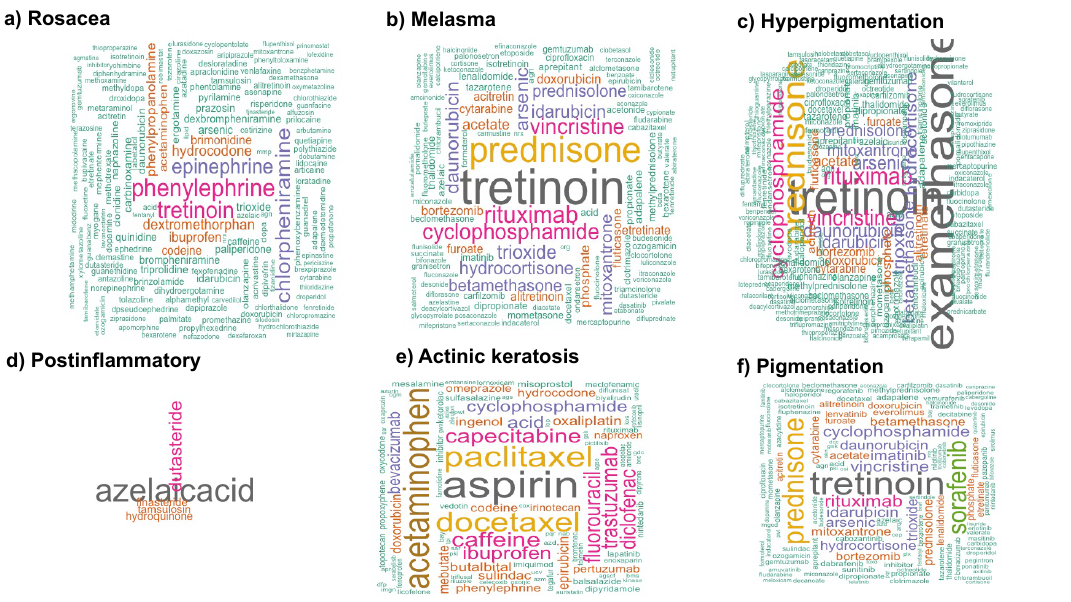
Figure 4. Word cloud shows the most common drugs for each